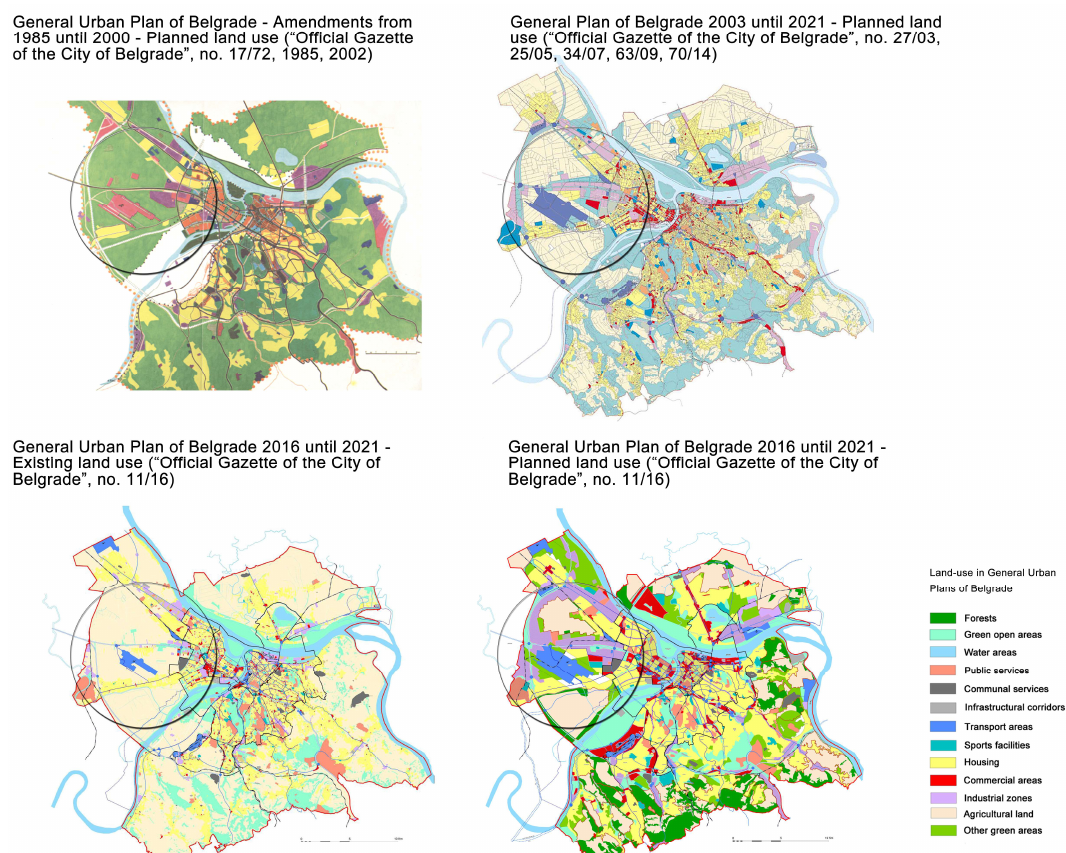
Figure 6. Generations of General Urban Plans for Belgrade (1985–2016). Source: